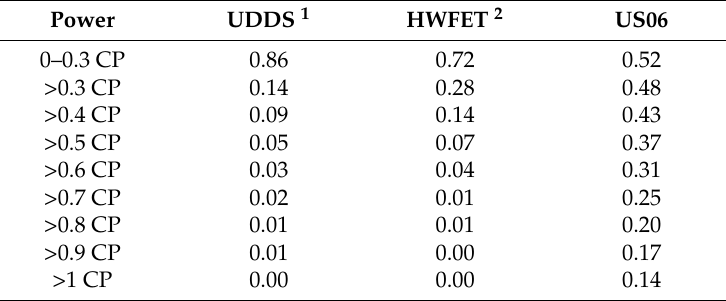
Table 2. Power distribution on different driving